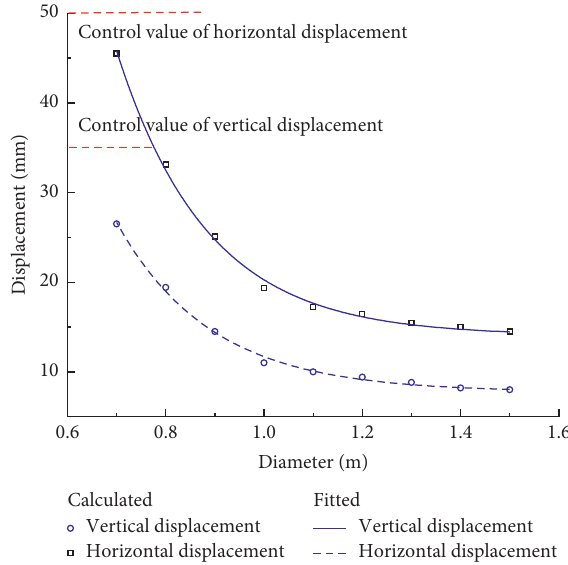
Figure 10: The influence of pile diameter on maximum